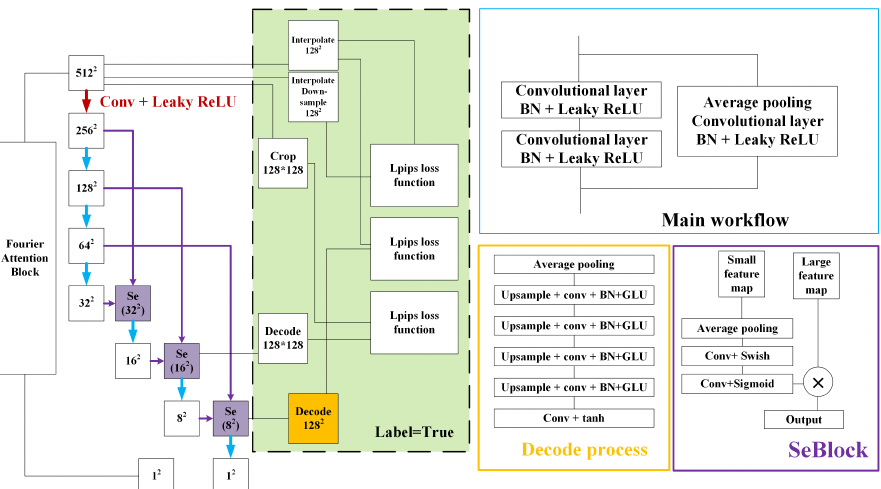
Figure 2. The structure of the discriminator. The blue box and blue arrows represent the main workflow, which is a residual structure with several layers. The red arrow represents the workflow containing the convolutional layer and the Leaky ReLU activation function. The purple boxes and arrows represent the process of the skip-layer excitation block (SeBlock). Two inputs are combined by each SeBlock module to create one output, which is then passed on. The numbers in the SeBlock represent the size of the processed image. The orange boxes and arrows represent the decoding process. The green solid box represents the extra computation only required for real images during the training